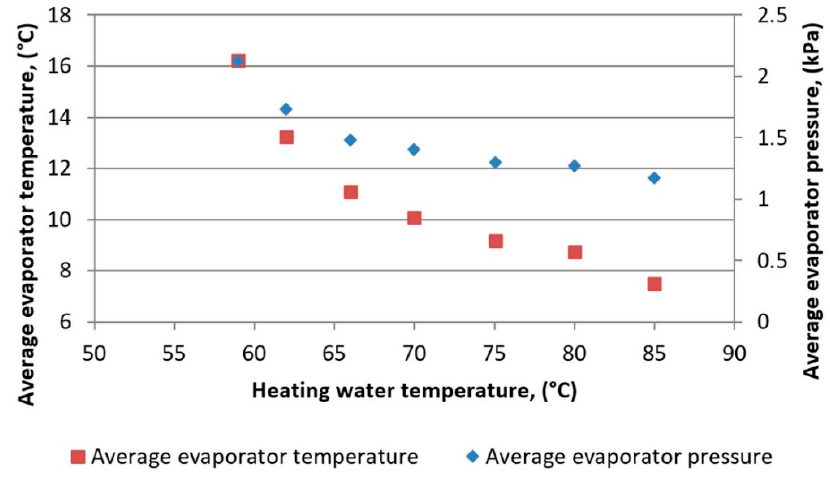
Figure 6. The influence of the heating water temperature on the average evaporator temperature and the average evaporator pressure.